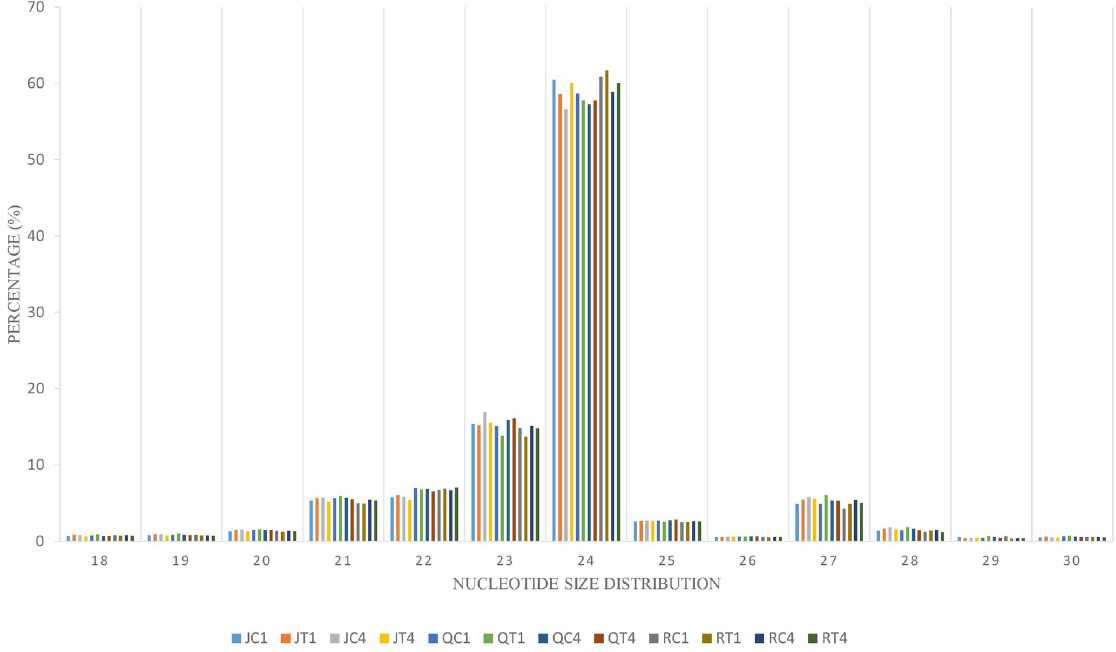
Fig 3. Nucleotide size distribution of endogenous siRNA. This graph depicts data from quinoa varieties (J, Q, R) with two treatments (C, T) at two time periods (days after inoculation [1,4]).J, Q, and R are initials of the varieties, and C and T are mock- and virus-inoculated, respectively.